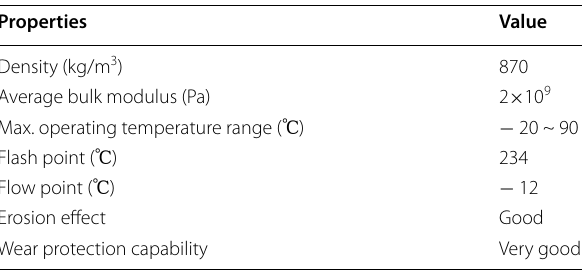
Table 4 Properties of L-HM46